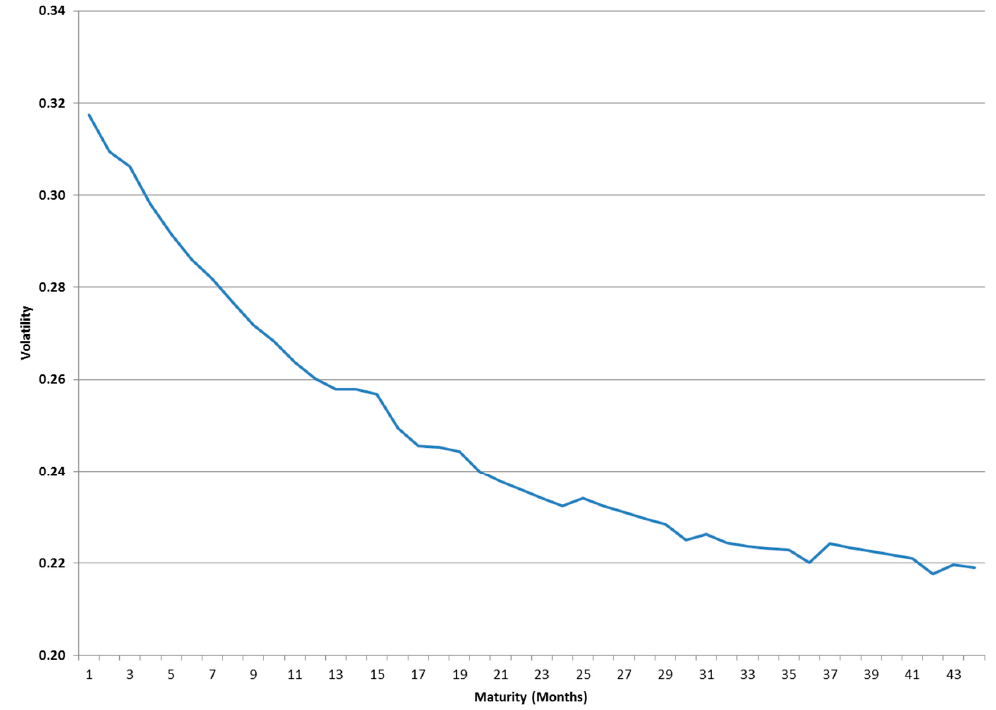
Figure 4. Return volatility as a function of the contract maturity over the sample period.